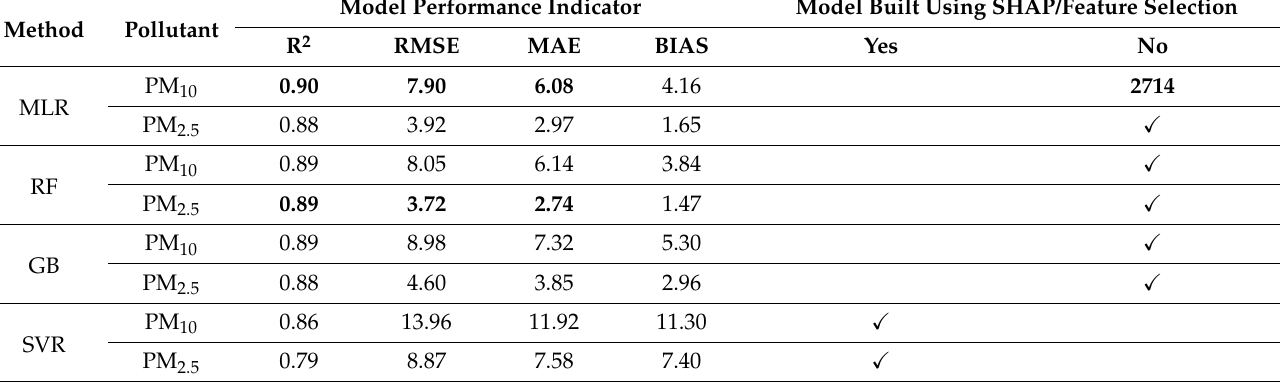
Table 4. Comparison of the MLR, RF, GB, and SVR models trained using 2013–2018 data and tested on 2021